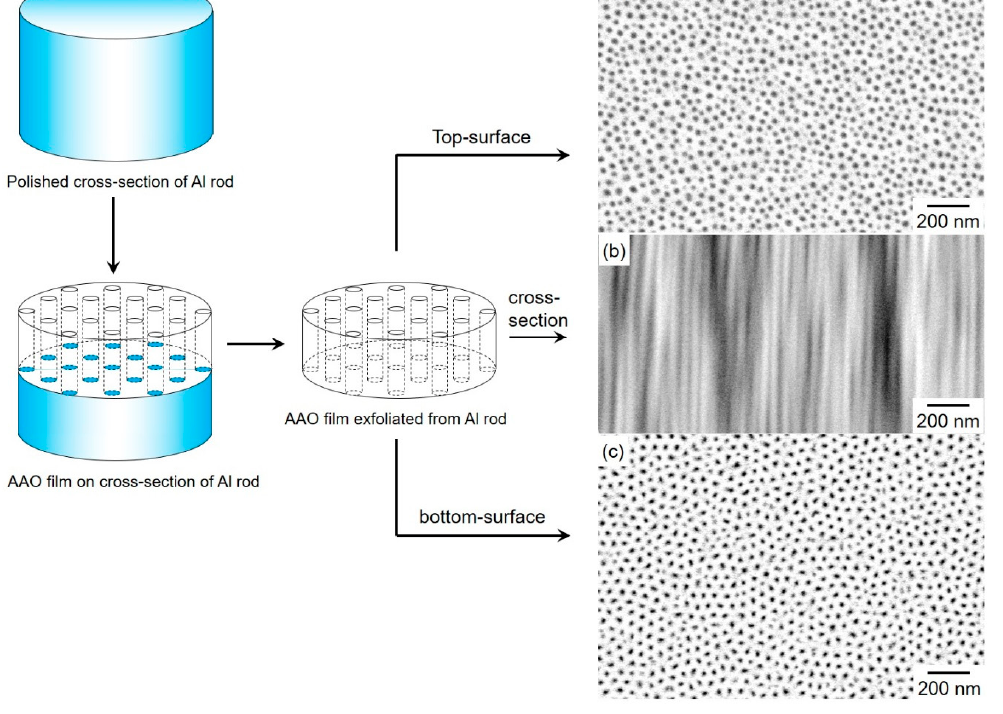
Figure 3. Scanning electron microscope (SEM) images of top-surface ( a ), cross-section ( b ) and bottom-surface ( c ) of anodized aluminum oxide nanochannel templates that were anodized at 20 V for 24 h. The electrolytic solution temperature was kept to 2 ◦ C during the